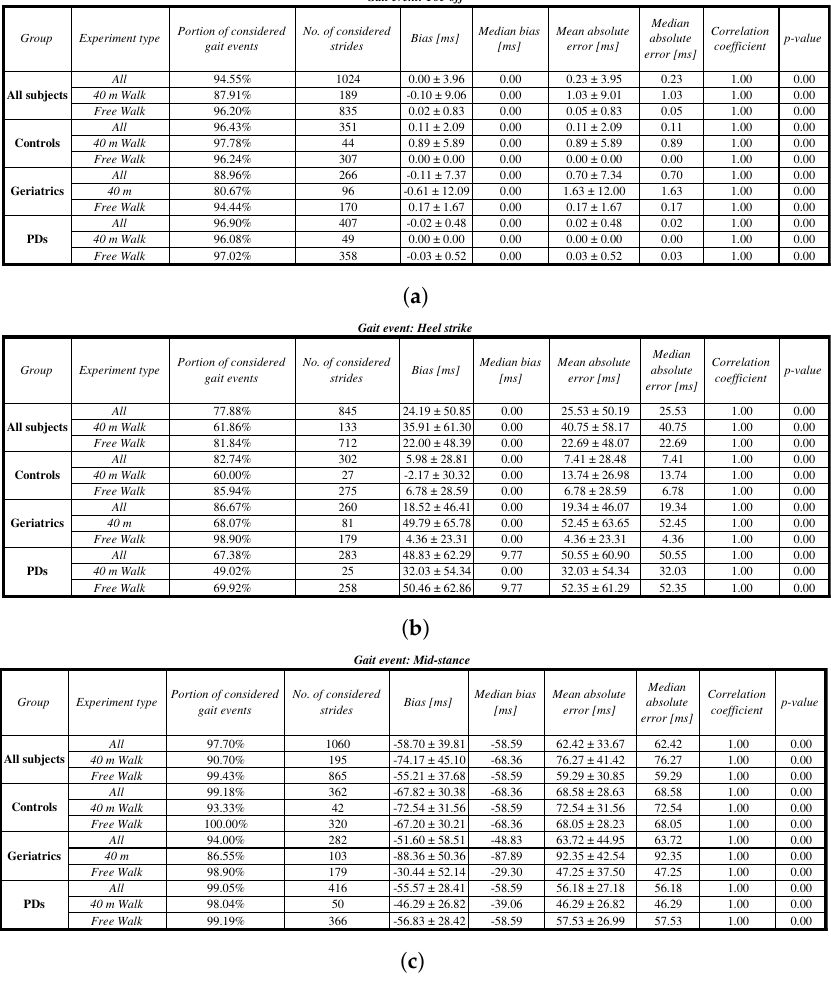
Figure 11. Performance of the proposed approach for detection of gait events, performed on the eGait dataset and validated with eGait system: (a) toe-off; (b) heel-strike; and (c) mid-stance. Matching between gait events detected with the proposed approach and ground truth